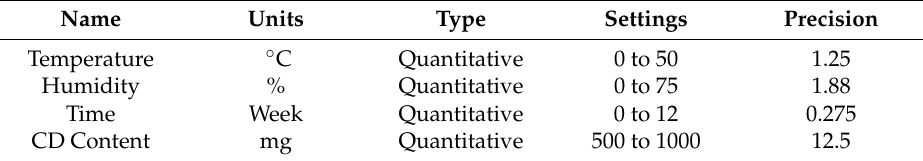
Table 1. Factor settings for the stability conditions used in the design of